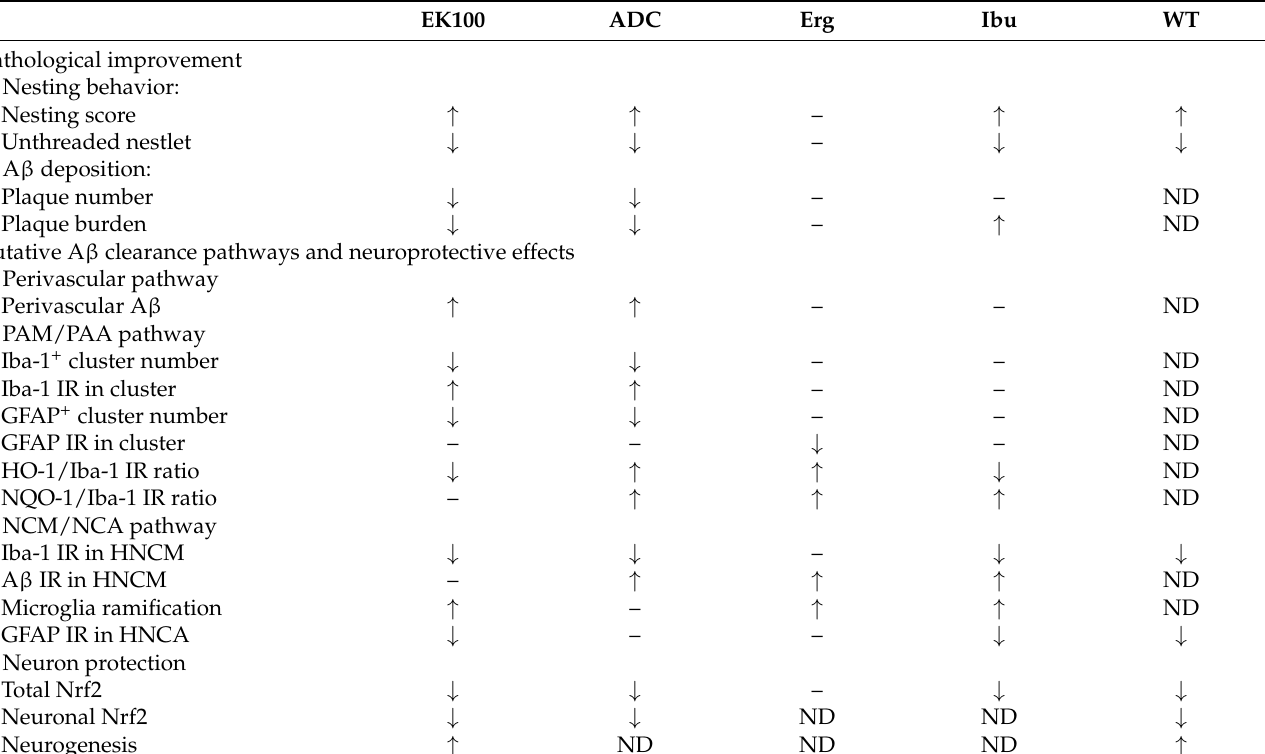
Table 2. The effects of four compounds in APP/PS1